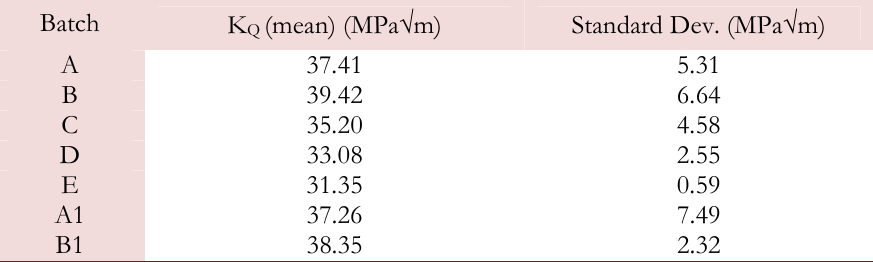
Table 2: Mean and standard deviation of the K Q